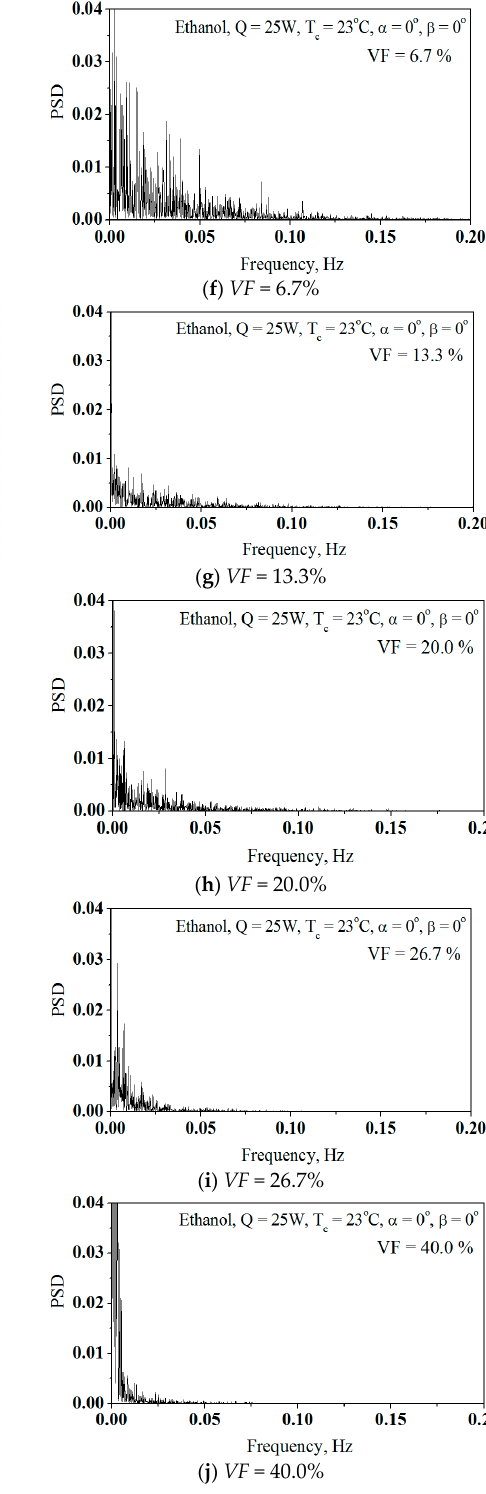
Figure 8. Transient Temperature Variation and FFT PSD Distribution (#No. 13), Q =25 W.